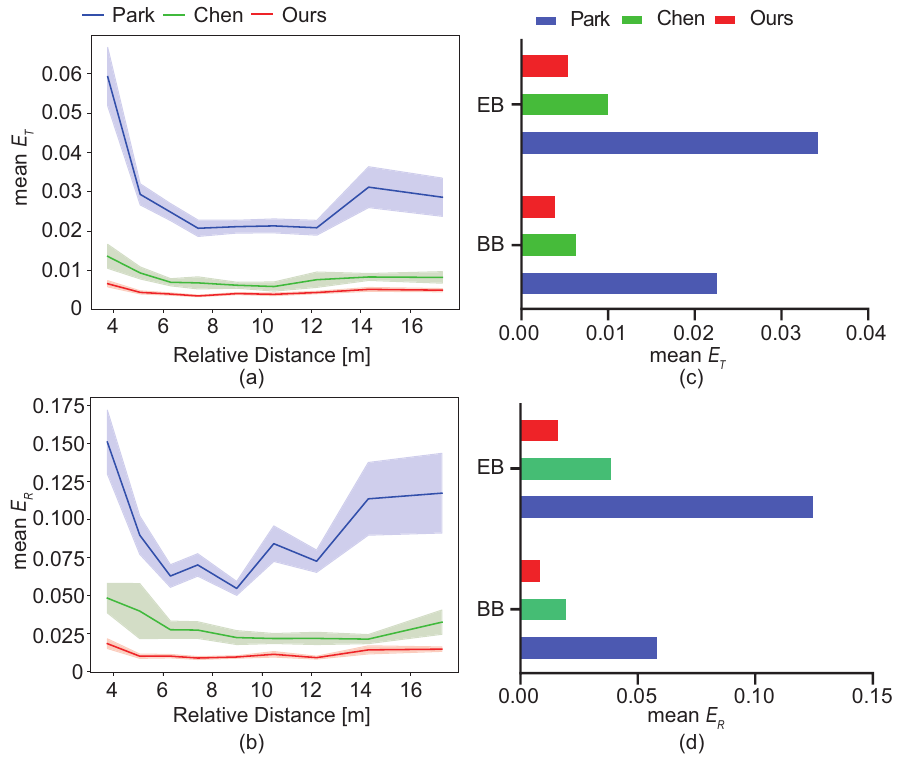
Figure 6. Performance in Different Relative Distance and Background. ( a , b ) show the change of meanE T and meanE R respectively with the relative distance between the spacecraft and the camera. ( c , d ) show the change of meanE T and meanE R respectively with the different backgrounds. EB represents the 506 images with the earth background in the test set, as shown in the bottom row in Figure 7. BB represents the 494 images with black background in the test set, as shown in the top row in Figure 7.